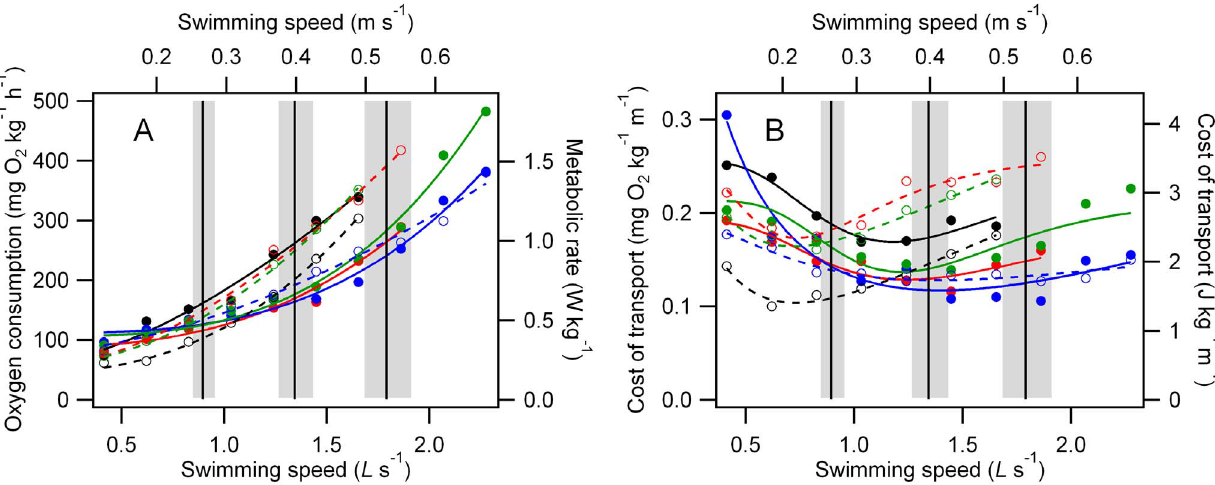
Figure 1. A. Rate of rainbow trout oxygen consumption during steady swimming. B. Total cost of transport during steady swimming. Vertical black lines and gray boxes show the mean 6 sem of the speeds used for blood flow measurements (0.50, 0.75, and 0.95 U max for each fish). Data from each individual are represented by a separate color/symbol type. Data in A are fitted with power functions, and B with log-normal functions. Dashed lines are associated with open symbols of the same color, and unbroken lines with closed symbols. Absolute swimming speeds shown on the top axis are an approximation based on mean fish length. Conversion of oxygen consumption rates to energy units was made with an oxycaloric value of 13.54 J mg 2 1 O